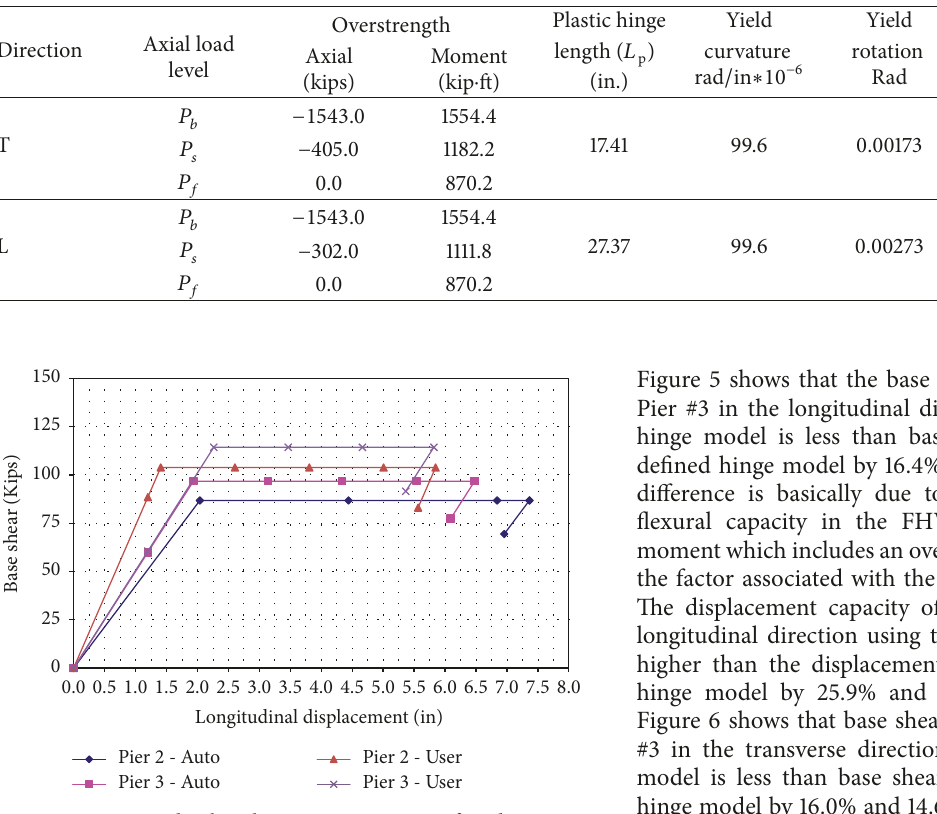
Figure 5: Longitudinal pushover capacity curve of Bridge #2-E.